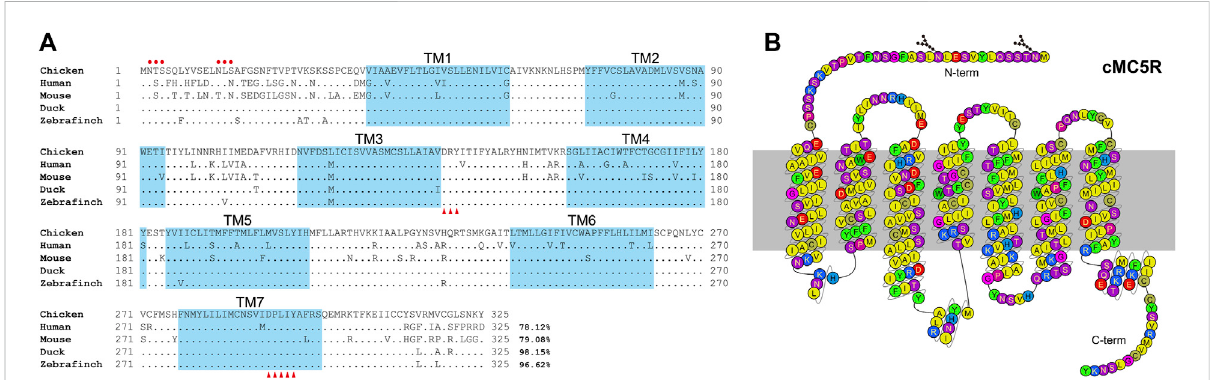
FIGURE 1 (A) Alignment of mature MC5R amino acid sequences among fi ve species. NCBI accession numbers of these sequences are OP259502 (chicken), NP_005904.1 (human), NP_038624.3 (mouse), XP_005018248.1 (duck) and XP_004175266.1 (zebra fi nch). The TM1-7 (seven transmembrane domains) are shaded in blue. The red dots indicate the predicted N-glycosylation sites. The conserved DRY motif and DPXXY motif weremarked with red triangles. “ . ” represents identicalamino acid, and “ − ” indicates a gap inthesequence alignment. (B) Snake-like diagram of the chicken MC5R receptor. Residues are colored based on their chemical properties. N-term represents the N terminal sequence, C-term represents the C terminal